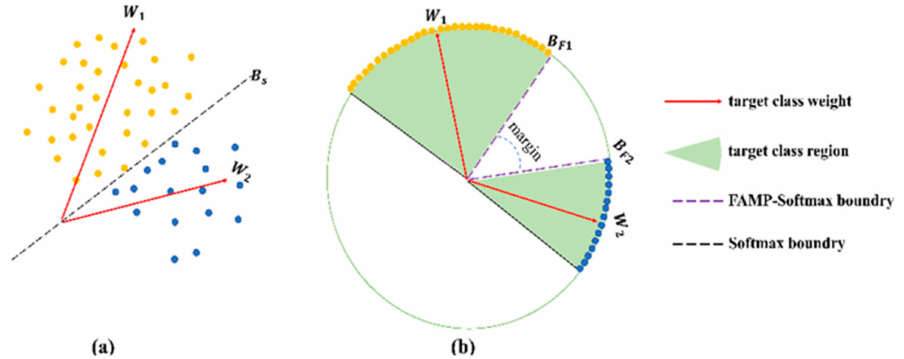
Figure 3. ( a ) Classification boundaries for Softmax ( b ) Classification boundaries for